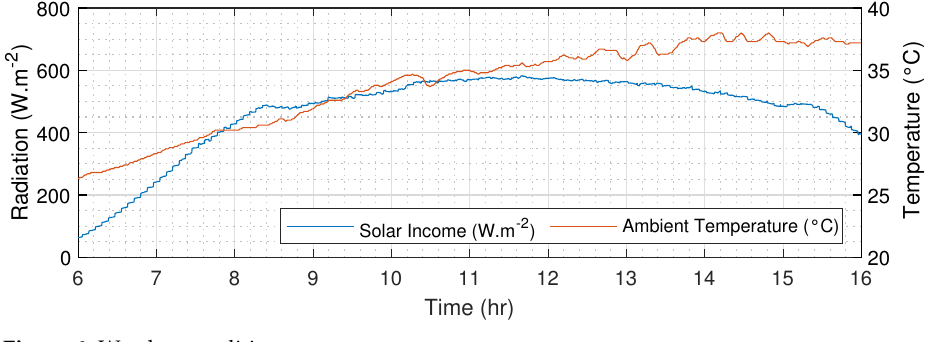
Figure 6. Weather conditions.